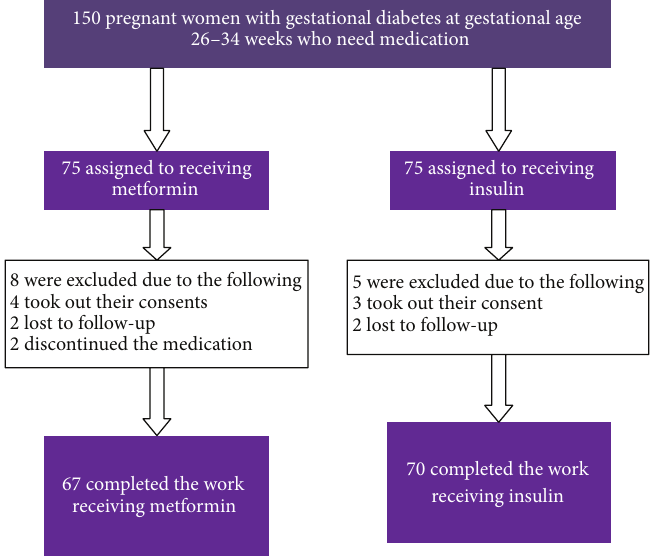
Figure 1: Study in flow chart.